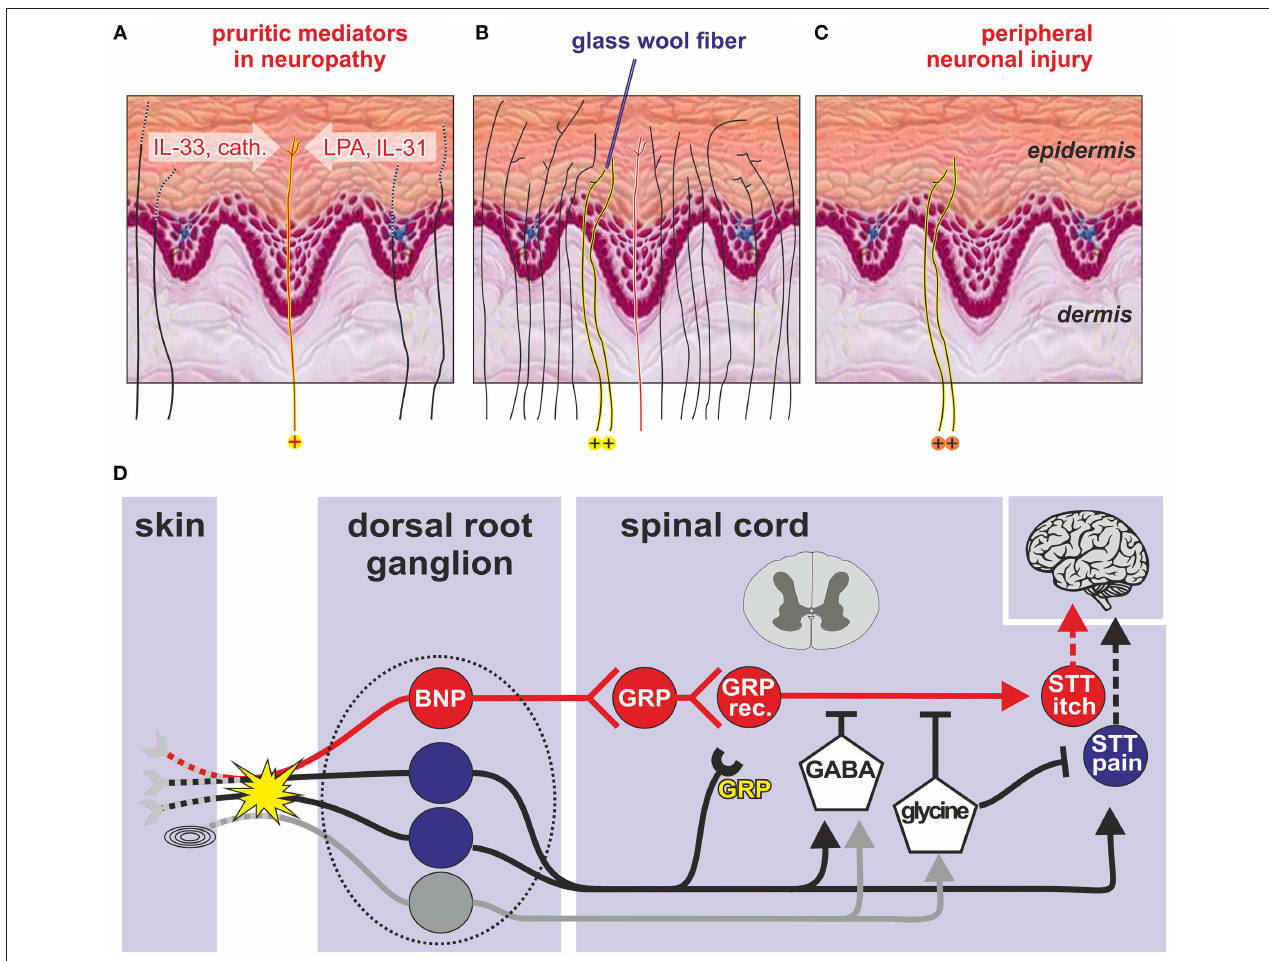
FIGURE 1 | Transduction of an itch in the skin (A–C) . (A) Degenerating peripheral nerve fibers (dotted lines) due to peripheral sensorineural injury may release inflammatory mediators such as LPA, IL-31, and IL33 ( 30) that activate itch-specific pruriceptors (red line, labeled yellow with “ + ” at bottom). The pruriceptors cause itching via activation of itch-specific pathways (red “labeled line”). (B) In healthy skin, itching can be caused when punctate stimuli (e.g., a glass wool fiber) activate only a few adjacent nociceptive fibers within the epidermis (labeled yellow with “ + ” at bottom) whereas directly adjacent fibers, including specific pruriceptors (red) remain silent. If instead activated en masse (e.g., by trauma) their combined activation will cause pain. (C) The same localized activation can be mimicked after peripheral neuronal injury when spontaneous action potentials from the few remaining abnormal epidermal nociceptors (labeled yellow with “ + ” at bottom) reproduce the discharge profile of non-lesioned skin (“spatial contrast mechanism” of itching). (D) Spinal processing of itching based on animal data: Skin and mucosal BNP primary sensory neurons (red) with cell bodies in the dorsal root ganglion (dotted line) stimulate GRP-releasing interneurons in the dorsal horn of the spinal cord